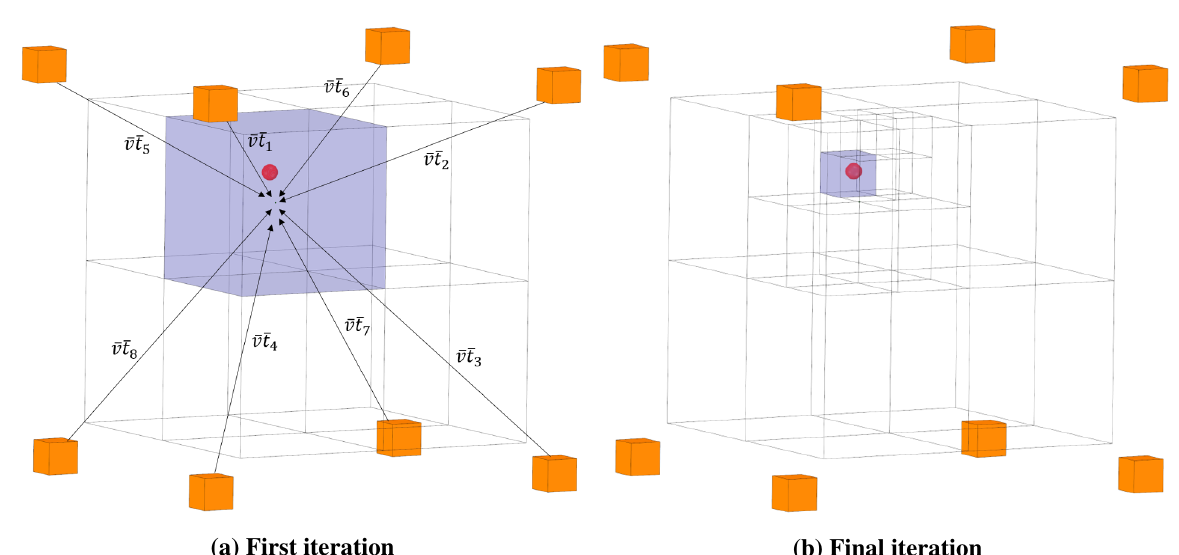
Figure 4: Convergence of iterative VBO to determine the optimal best fit parameter for the system, ¯ v .